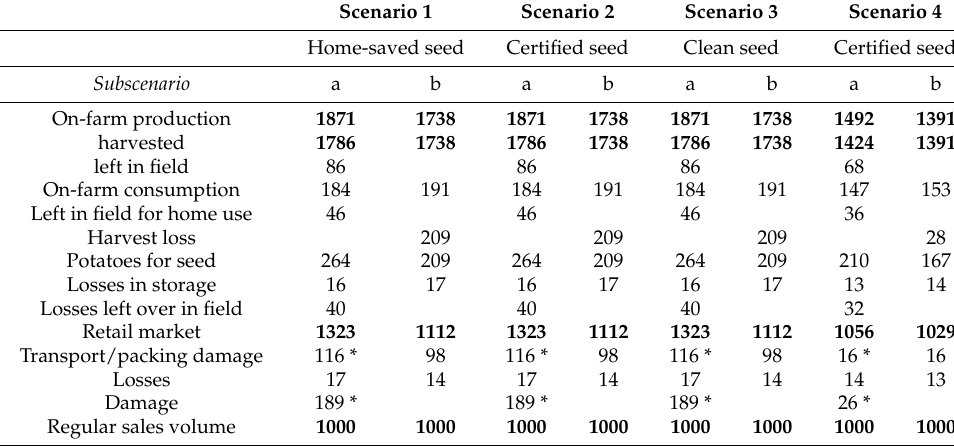
Table 7. Backward Calculation of Flows from Farm to Retailer (all in kg), Starting from 1000 kg of Marketable Produce at the Point of Sale. Totals indicated in bold, losses in plain